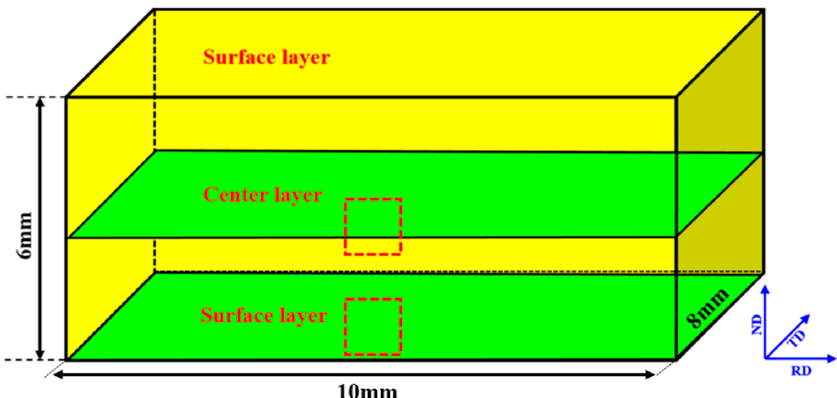
Figure 1. Examined positions for X-ray diffraction (XRD) and electron backscatter diffraction (EBSD) (XRD examined zone is the green shaded plane, while the red dashed frame stands for the EBSD examined plane).